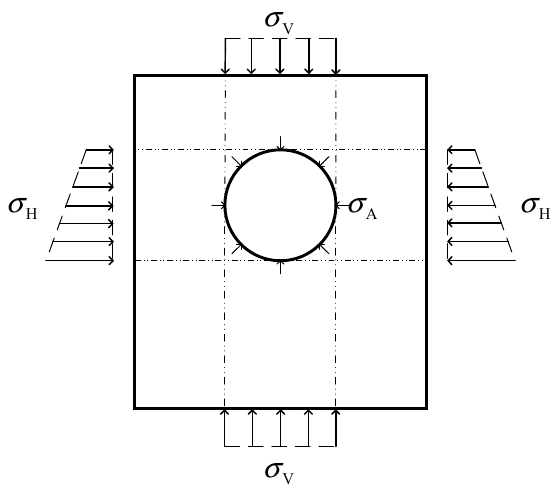
Figure 16. Diagram of the calculation section.